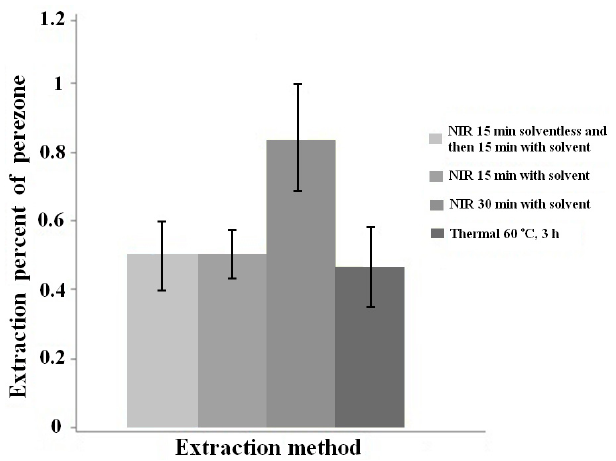
Figure 1. Comparison of extractions percent between NIR and MH methods.